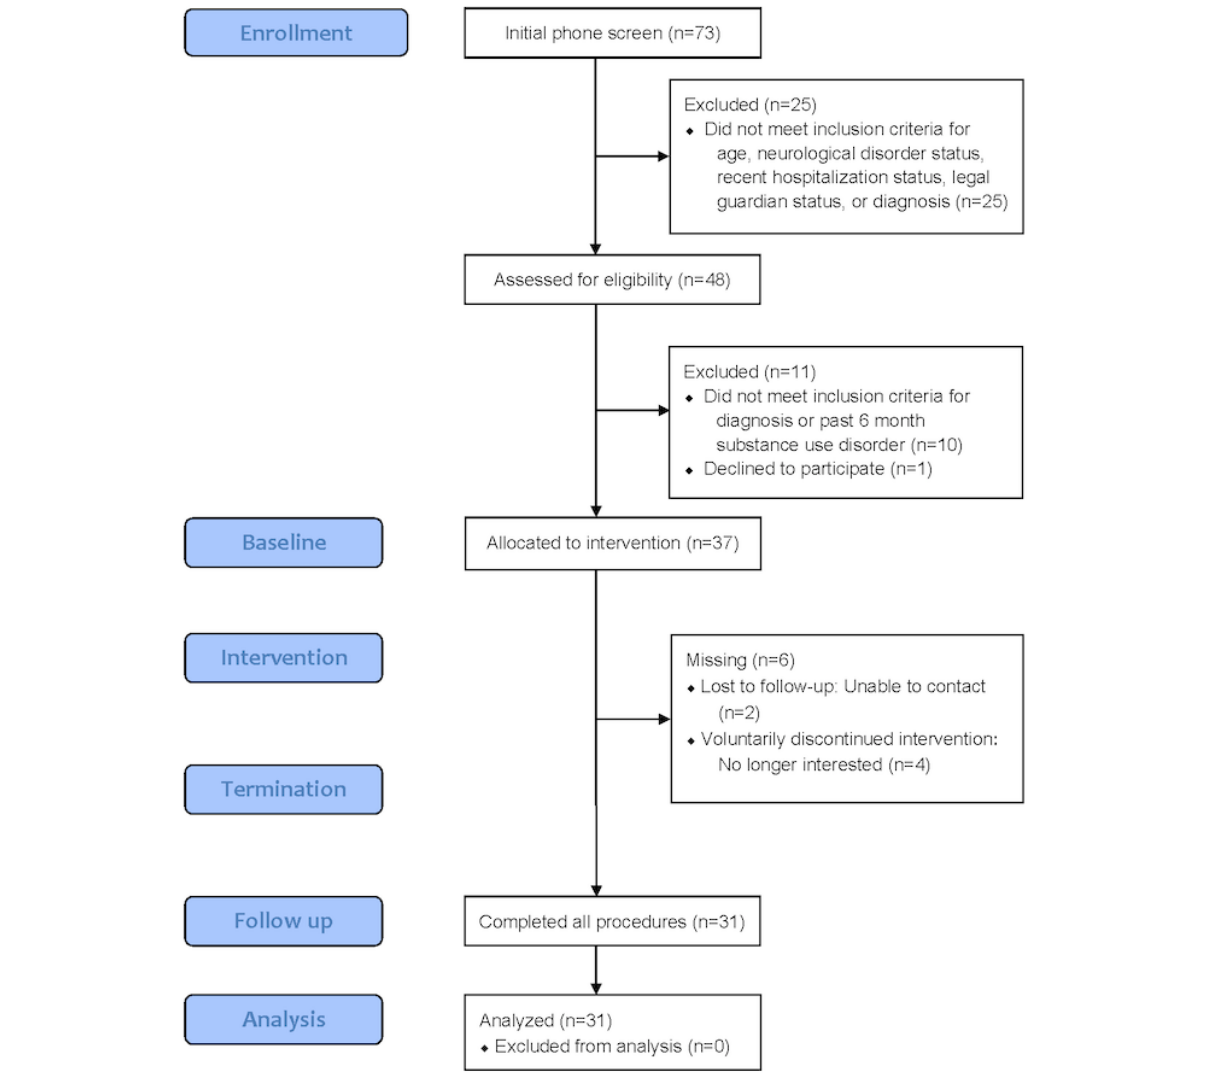
Figure 2. CONSORT (Consolidated Standards of Reporting Trials) chart for the Motivation and Skills Support app open